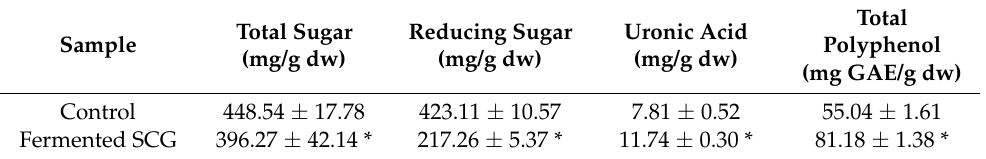
Table 1. Total sugar, reducing sugar, uronic acid, and polyphenol contents in fermented SCG after 8 days of submerged